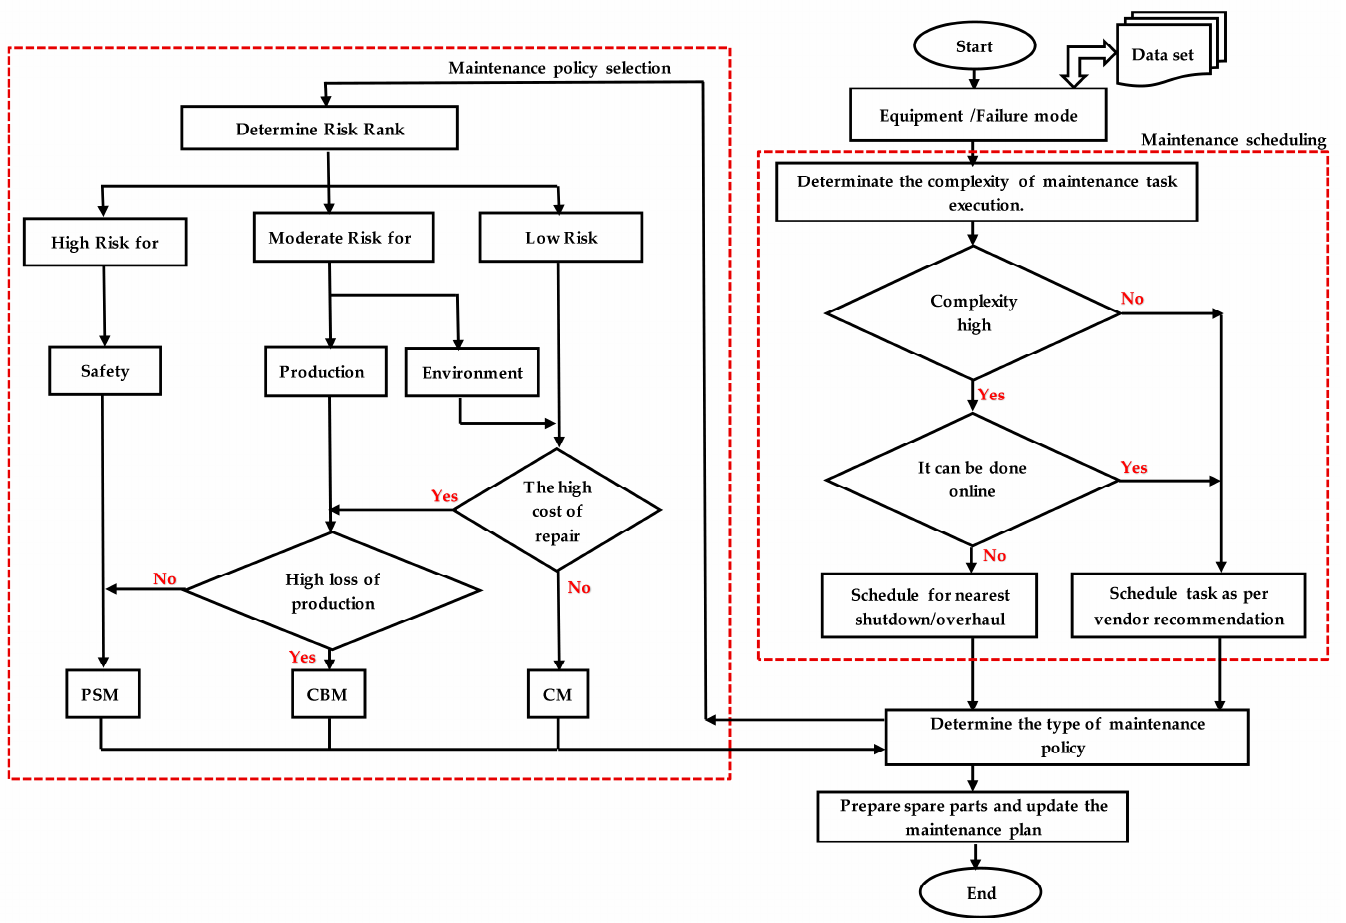
Figure 3. The proposed developed maintenance decision tree (DMDT).